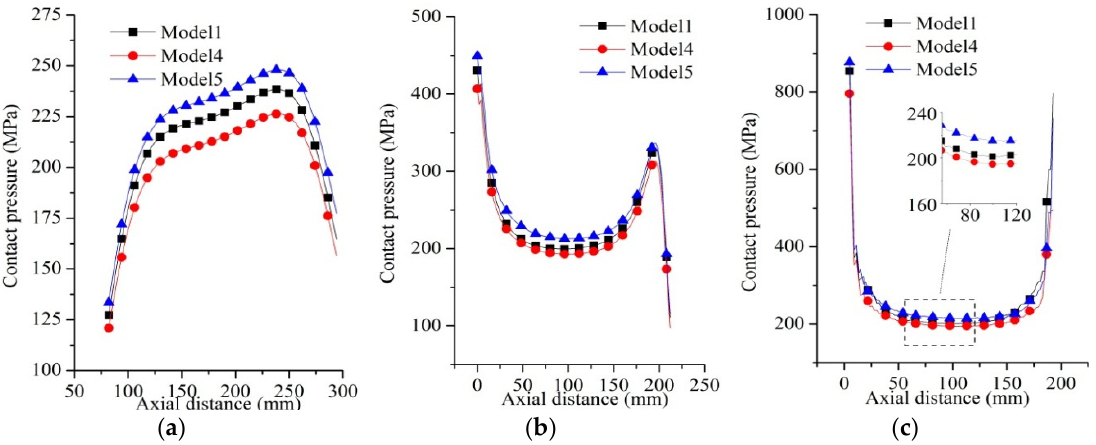
Figure 7. Distribution of the contact pressure on each mating surface under different machining deviations. ( a ) Mating surfaces of shaft and sleeve; ( b ) mating surfaces of sleeve and inner ring; ( c ) mating surfaces of inner ring and outer ring.